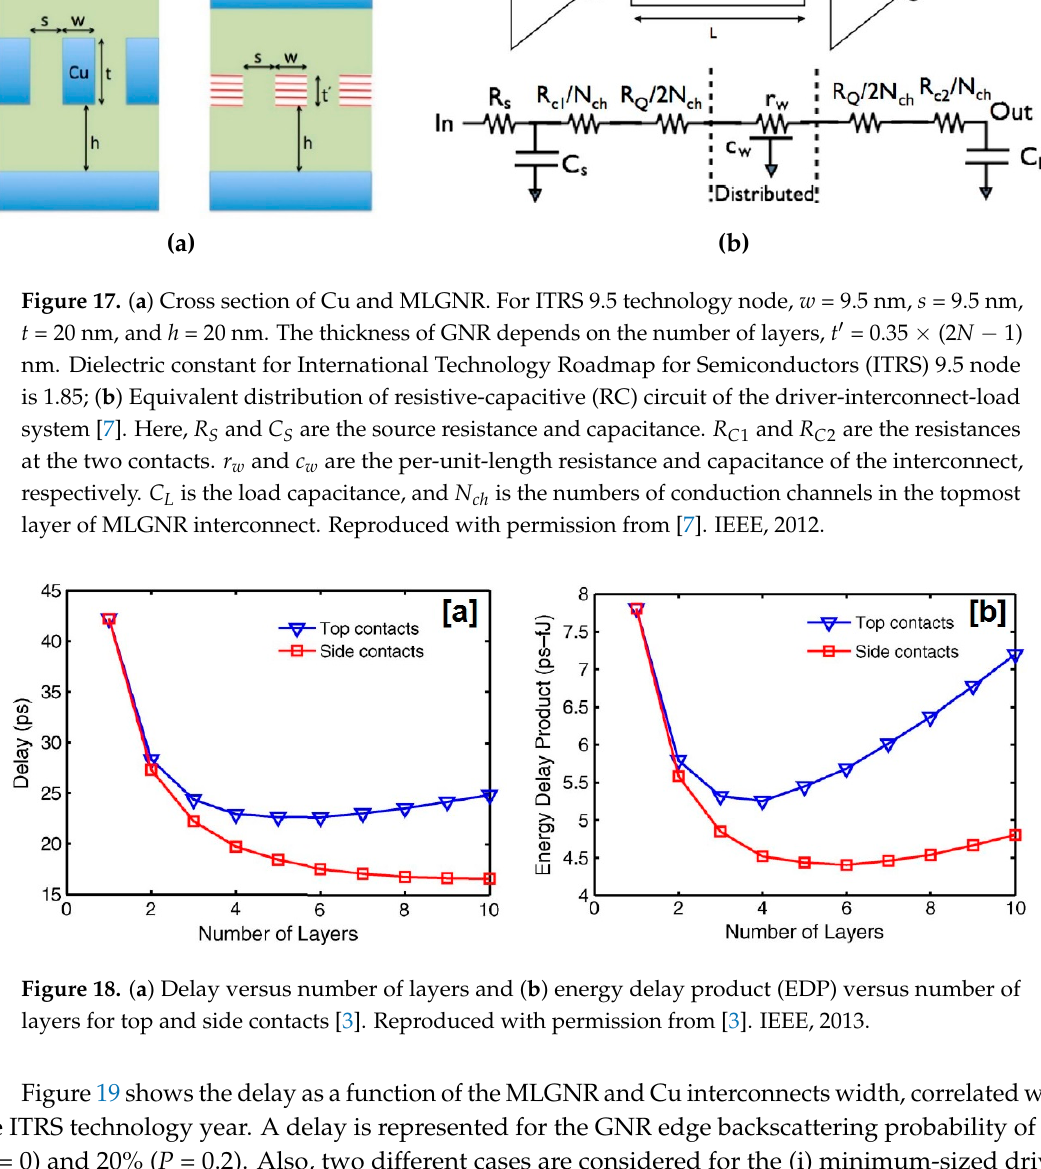
17 of 27 Figure 16. Capacitance per unit length of graphene sheet consisting of different numbers of graphene layer as a function of width [76]. Reproduced with permission from [76]. IEEE, 2015. 6.3. Delay and EDP After the individual comparison of the resistance and capacitance of the graphene nanoribbon interconnects with the Cu interconnects, as discussed in the previous section, the propagation delay and energy delay product (EDP) of MLGNR is compared with the Cu interconnects [3,7] in this section. The cross sections of the Cu and MLGNR interconnect are shown in Figure 17a, and the schematic of the circuit delay is shown in Figure 17b. The 50% system delay expressions for the